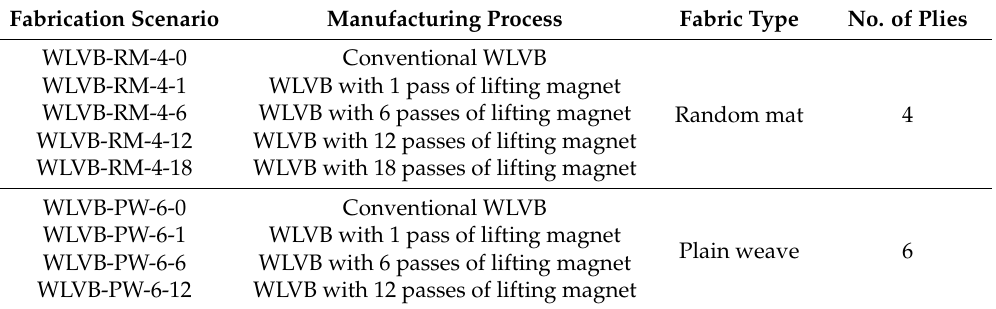
Table 2. Designations for the laminates fabricated with different fabric types and different manufacturing